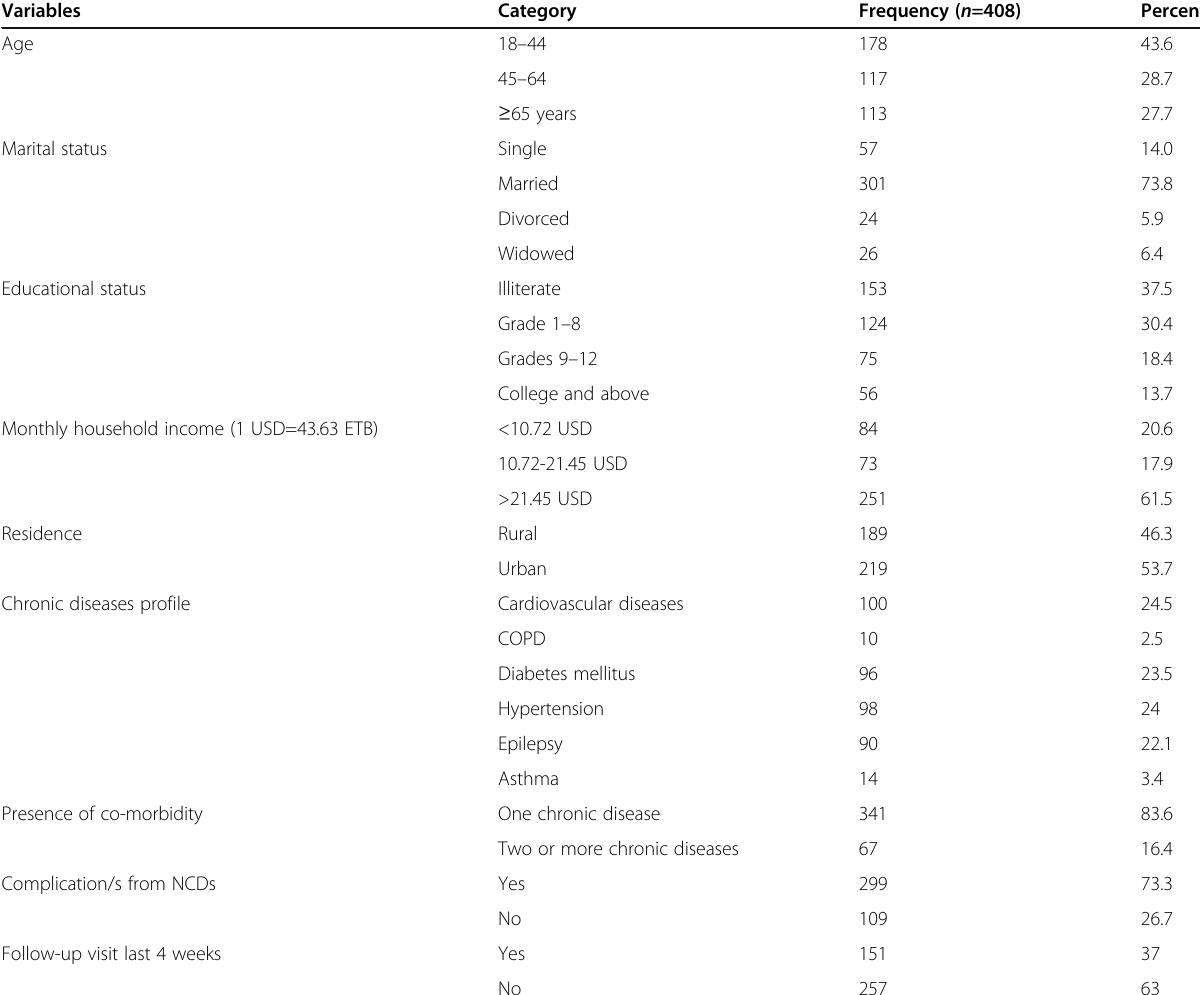
Table 1 Sample characteristics in JMC, Ethiopia ( n =408)